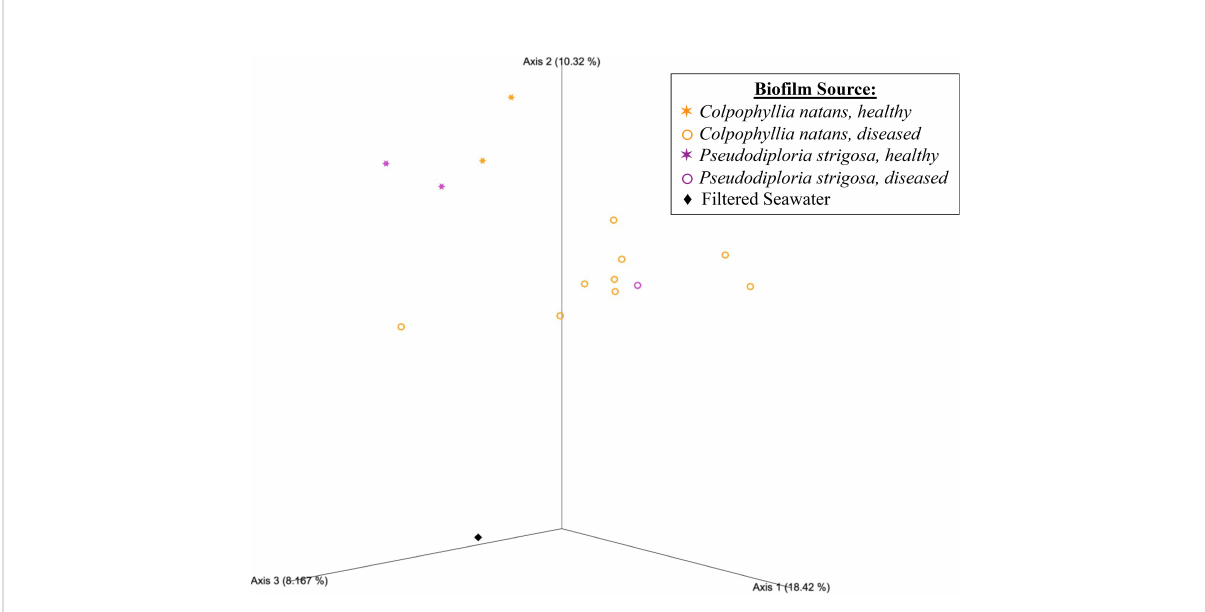
FIGURE 3 Emperor principal coordinates analysis plot based on an unweighted UniFrac distance matrix, illustrating the relationships between the bio fi lm bacterial/ archaeal communities sourced from mesocosms containing different donor types, including Colpophyllia natans (in orange), Pseudodiploria strigosa (in purple), and fi ltered seawater (FSW; black diamond). Health status of the donor coral is also indicated, with healthy corals represented by stars ( ✶ ) and diseased corals by open circles ( 〇 ). Axis percentage values indicate the percent variation explained by that axis.